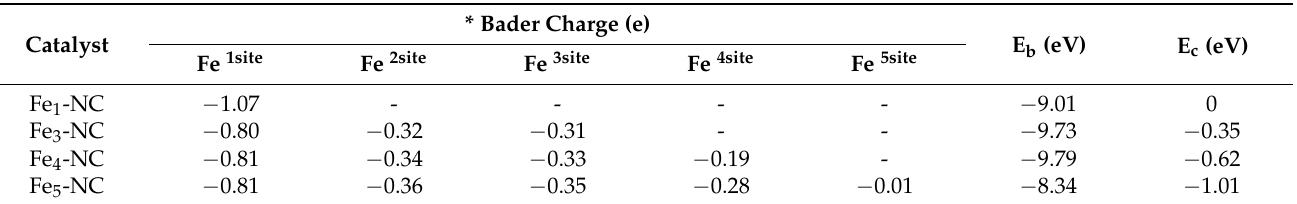
Table 1. The Bader charge of Fe atom in various Fe n -NC, binding energies ( E b ) between the Fe n cluster and NC, and the cohesive energy ( E c ) of Fe atoms in various Fe n clusters.